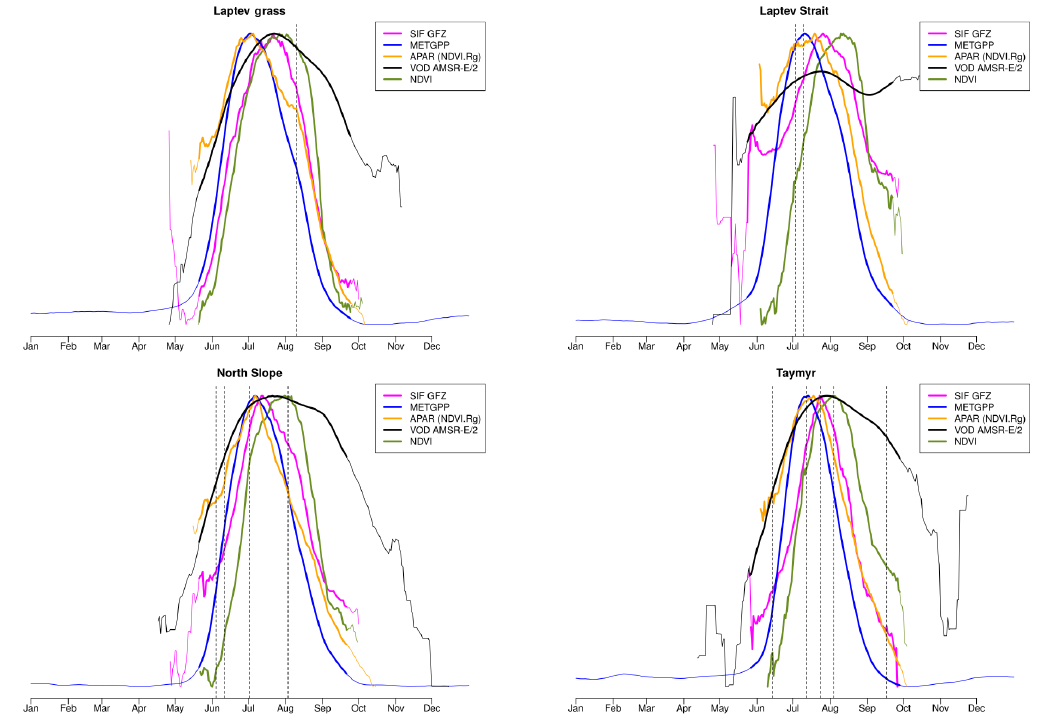
Figure A19. Mean seasonal cycles of selected proxies averaged over smaller regions, as indicated in Fig.